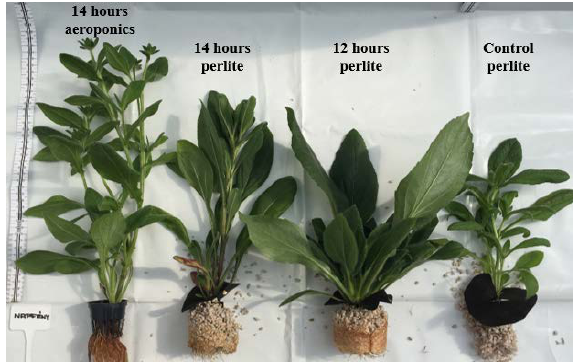
Figure 1. 16 weeks-old Rudbeckia hirta ’ Napfény’ plantlets depending on photoperiodic lighting treatments and media (University of Debrecen, Biological Research and Plant Experiment Greenhouse - Biodrome, Debrecen, Hungary, 2021) .